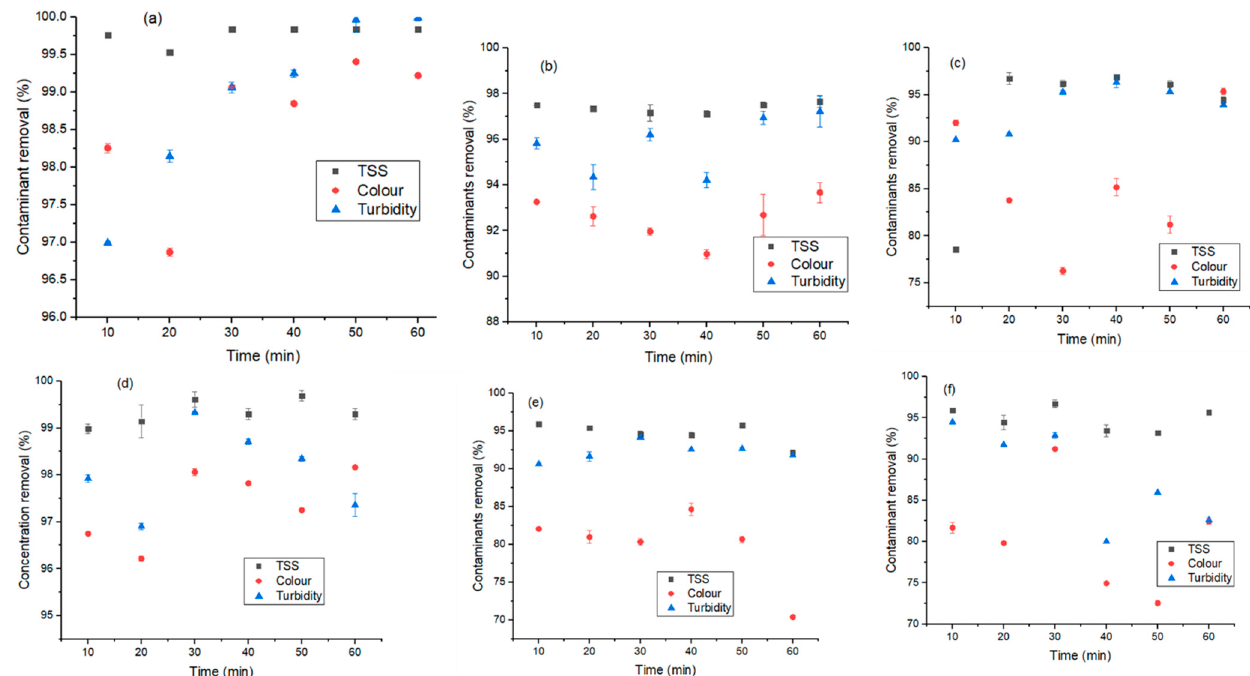
Figure 5. Effect of settling time (min) on contaminant removal (TSS (black), color (red), and turbidity (blue)) at 20 mg/L, using: ( a ) alum, ( b ) eggshells, ( c ) ferromagnetite, ( d ) FA, ( e ) FE, and ( f ) FEA. Molecules 2020 , 25 , x FOR PEER REVIEW